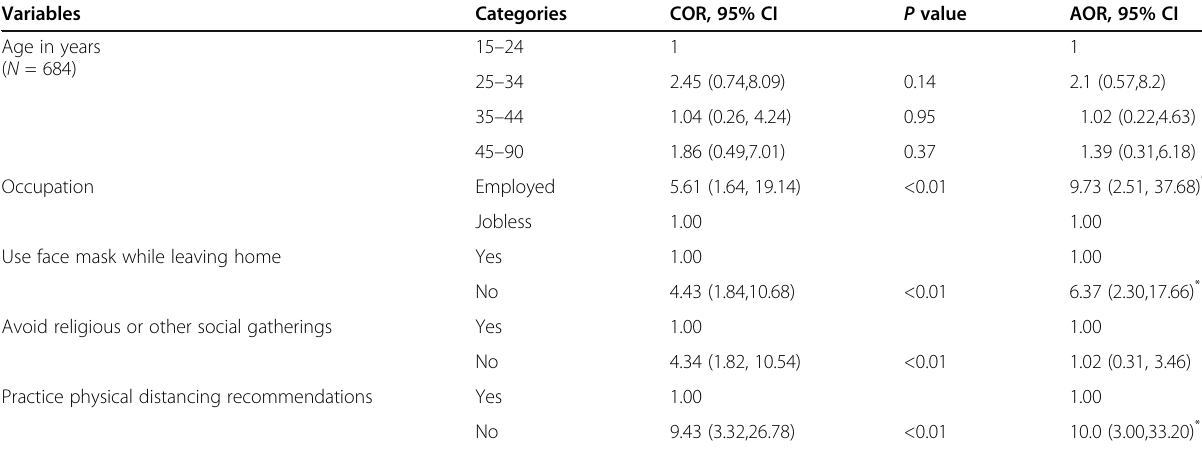
Table 4 Multilevel mixed effects multivariate logistic regression analysis for predictors of SARS-CoV-2 seroprevalence among individuals aged above 15 years in Dire Dawa, Ethiopia,